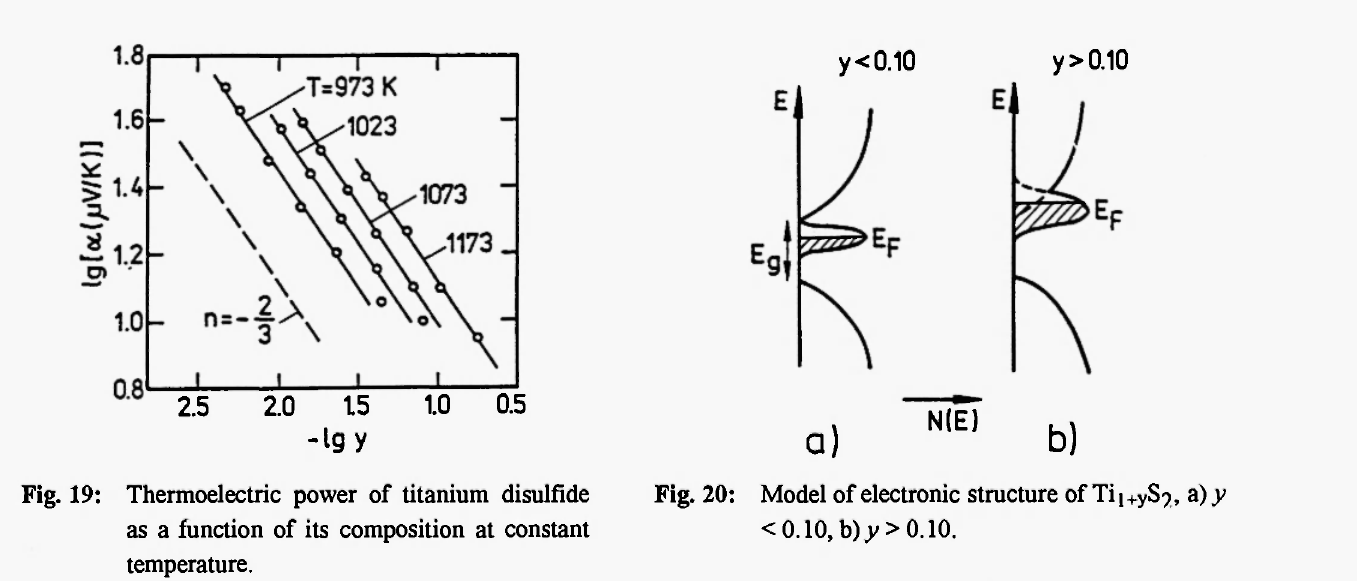
Fig. 20: Model of electronic structure of Ti ι < 0.10, b),y >